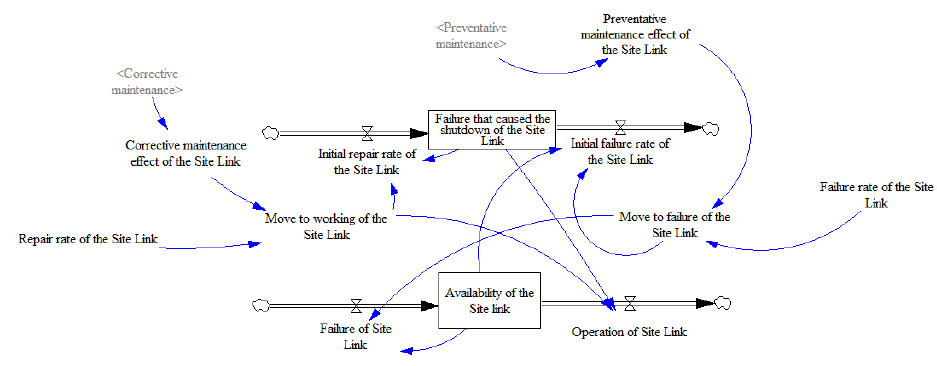
Figure 5. Site link model.